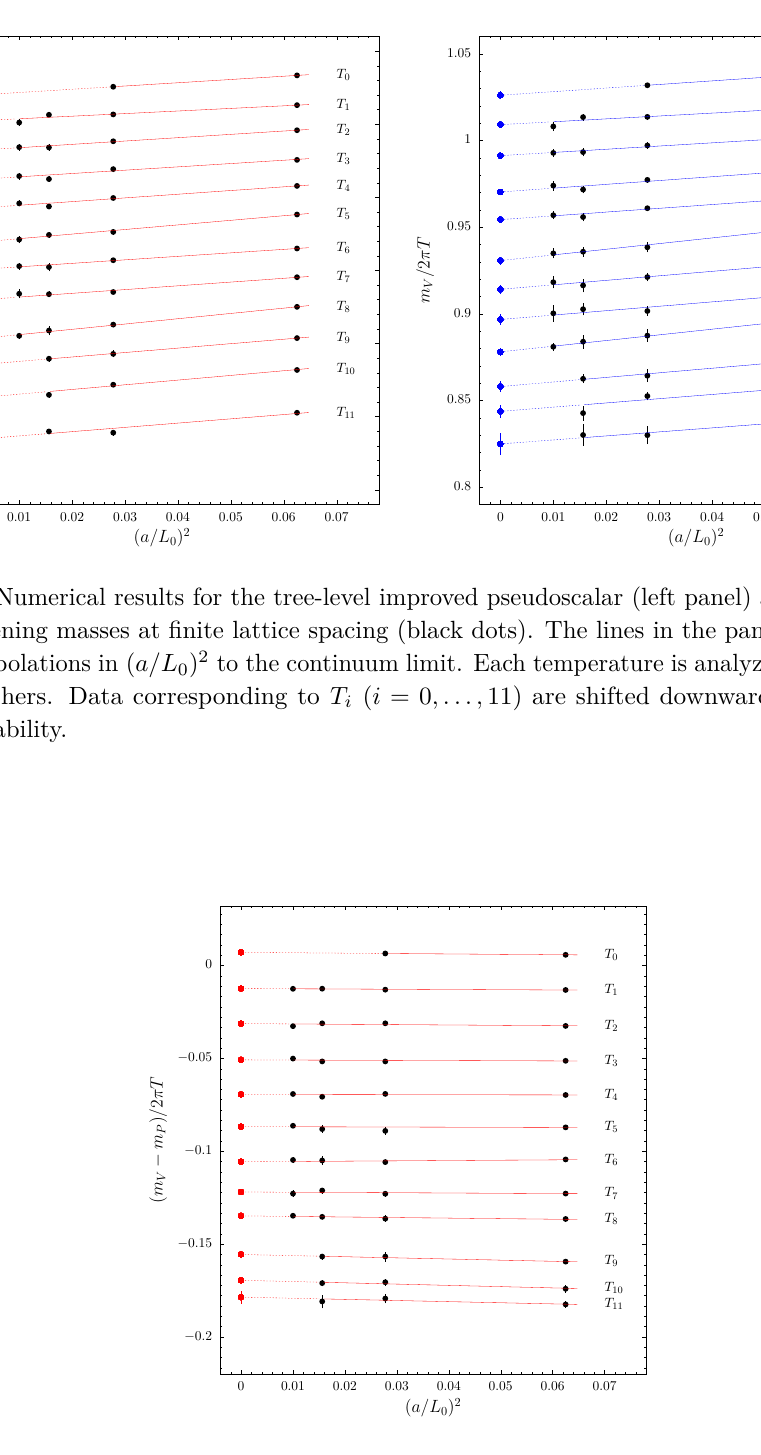
Figure 3 . As in figure 2 but for the mass